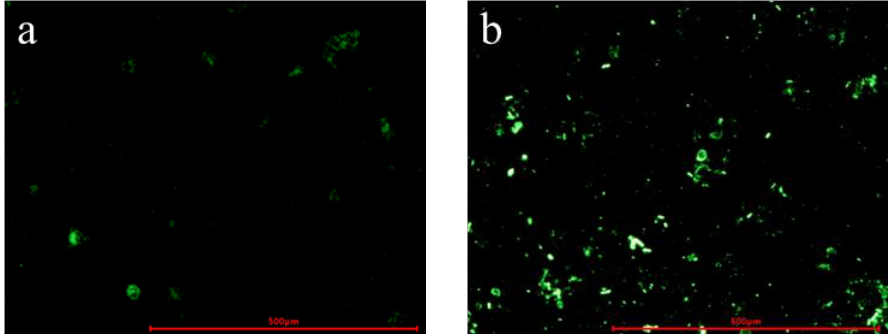
17 of 21 Figure 10. HCT-116 cell viability rates following 24 h treatment with Cur, MSN-NH 2 -AOS (mass of MSN-NH 2 -AOS carrier containing the same amount of Cur), and MSN-NH 2 -Cur-AOS nanoparticles (* p < 0.05; ** p < 0.01) ( a ). Viability rates of L929 cells treated with different concentrations of MSN- NH 2 -AOS and MSN-NH 2 -Cur-AOS ( b ).